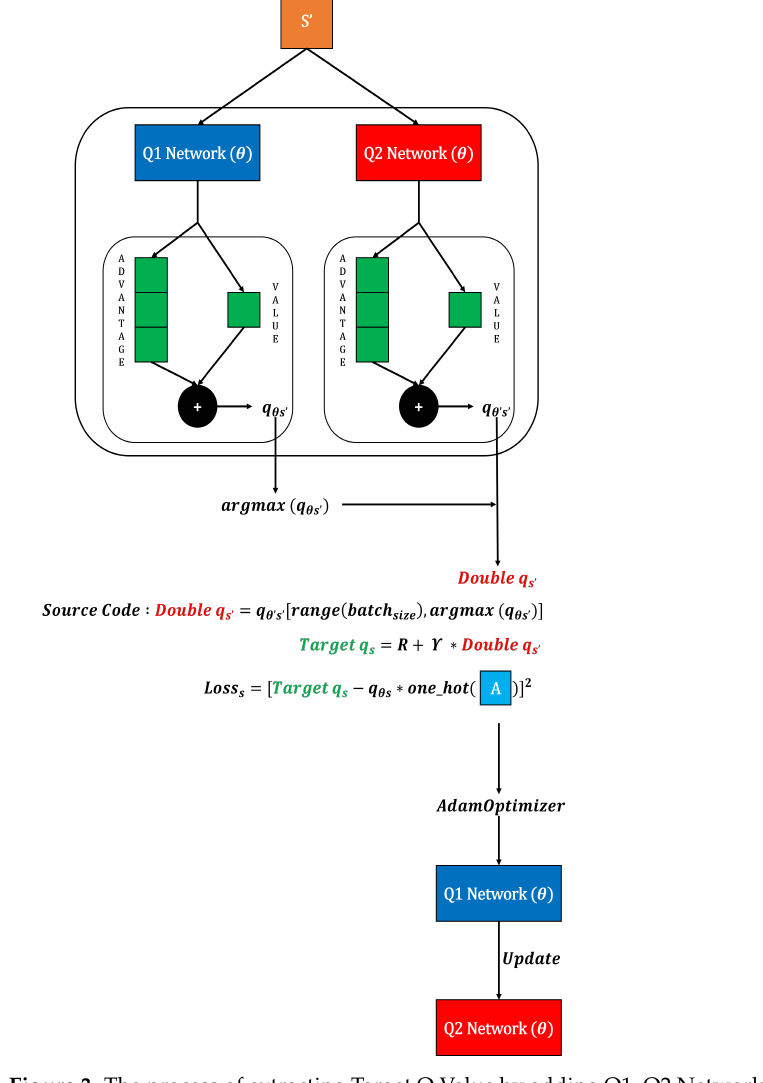
Figure 3. The process of extracting Target Q Value by adding Q1, Q2 Network, the idea of the Double DQN algorithm, to a Dueling DQN